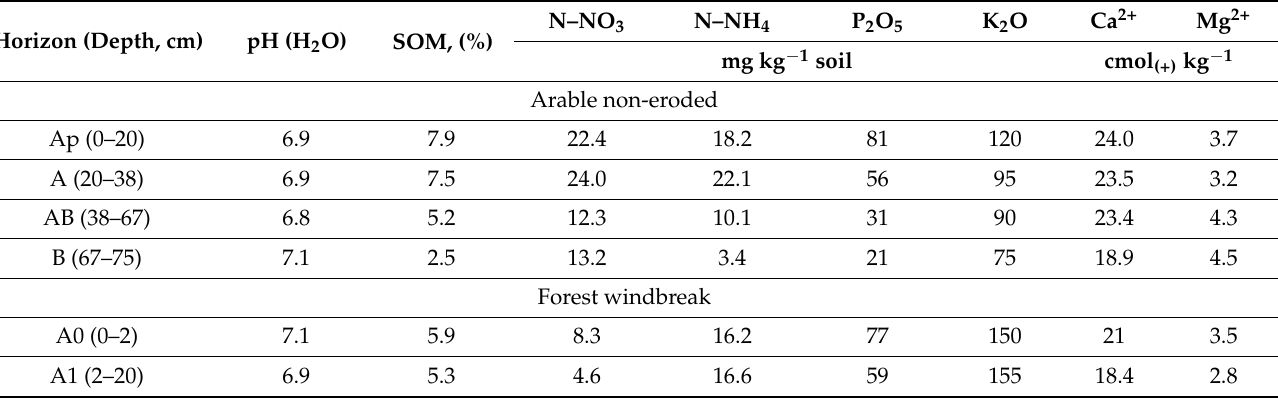
Table 5. Chemical properties of the chernozem